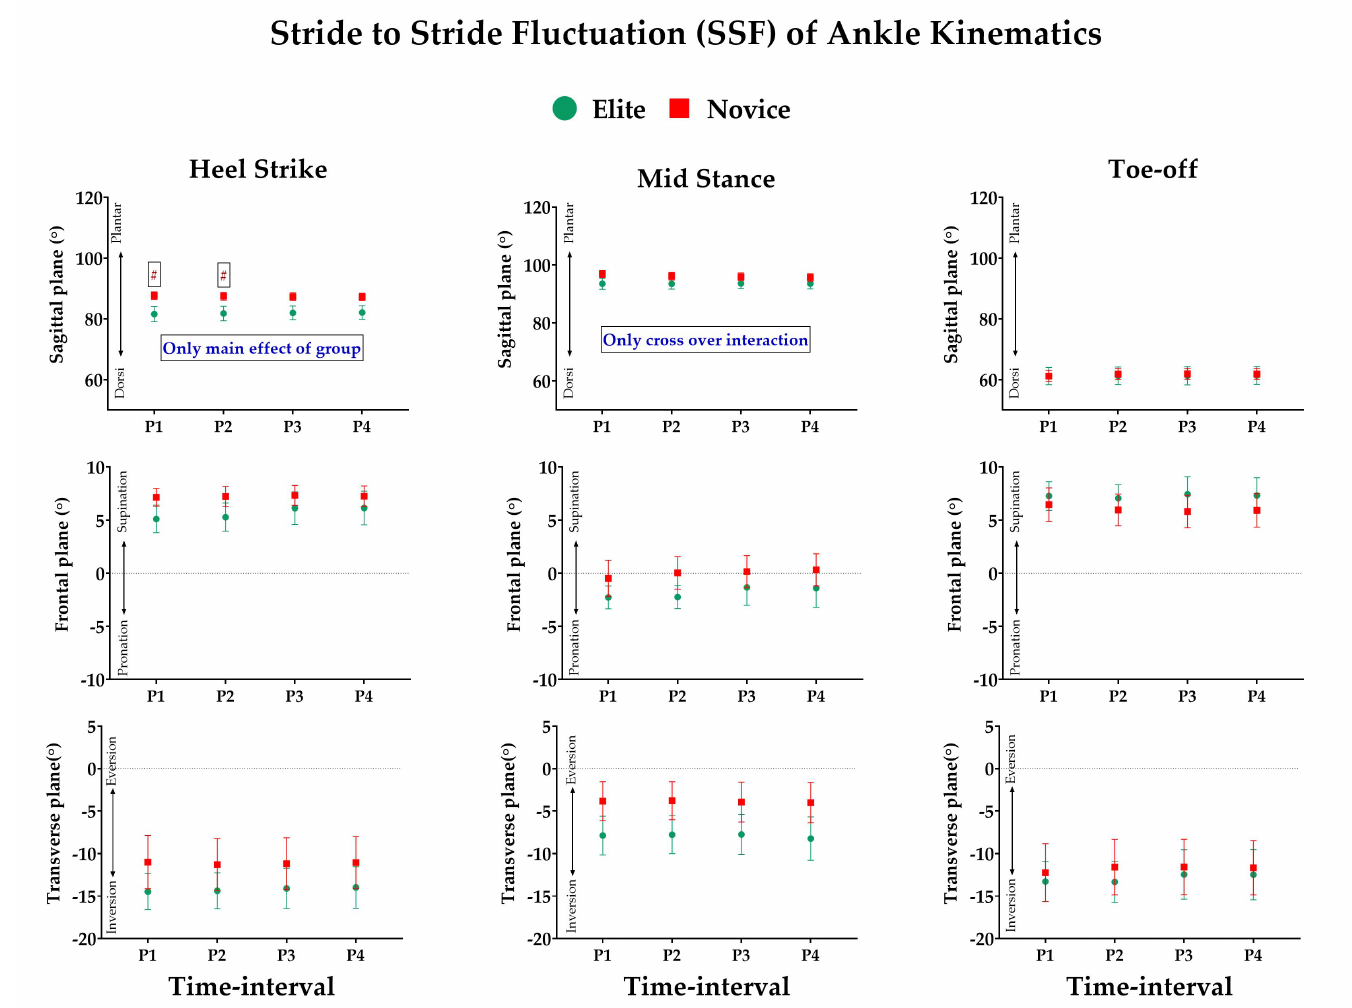
Figure A2. The results of the kinematics of ankle joint SSF angle between elites (circle) and novices (square) in each phase of the prolonged run. The computed variable of SSF is represented on the Y -axis. The time-interval calculated by increasing the window size every five minutes is represented on the X -axis (P1: 0 to 5 min; P2: 0 to 10 min; P3: 0 to 15 min; and P4: 0 to 20 min). The figure depicts a significant main effect of group, time interval, and interaction. Significant differences in a group for a specific time interval are marked with a “#”. (Note: only results with significant interaction have been